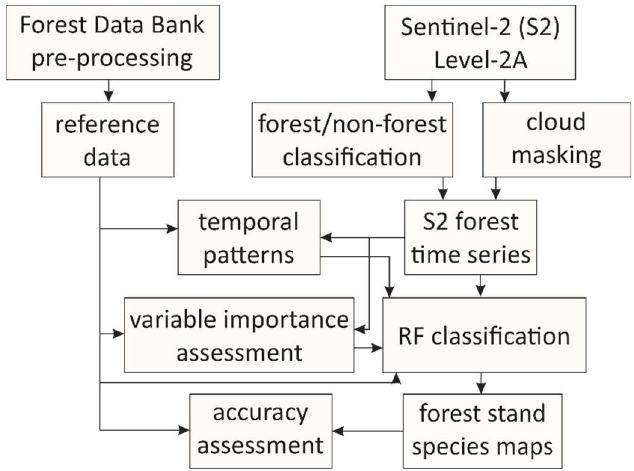
ff erent combination of Sentinel-2 time